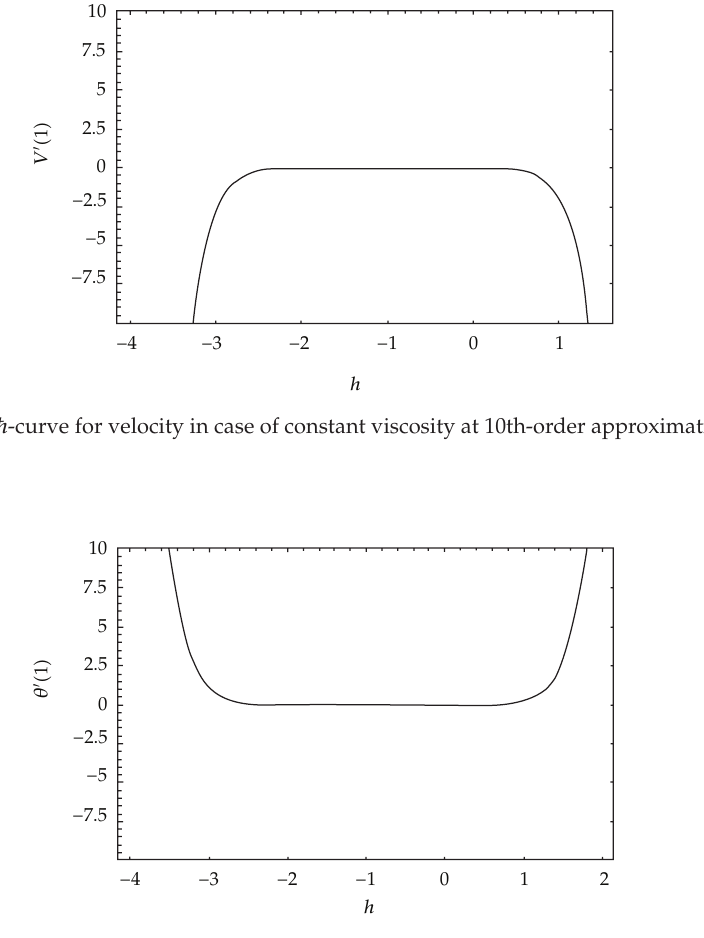
Figure 2: ħ -curve for temperature in case of constant viscosity at 10th-order approximation.